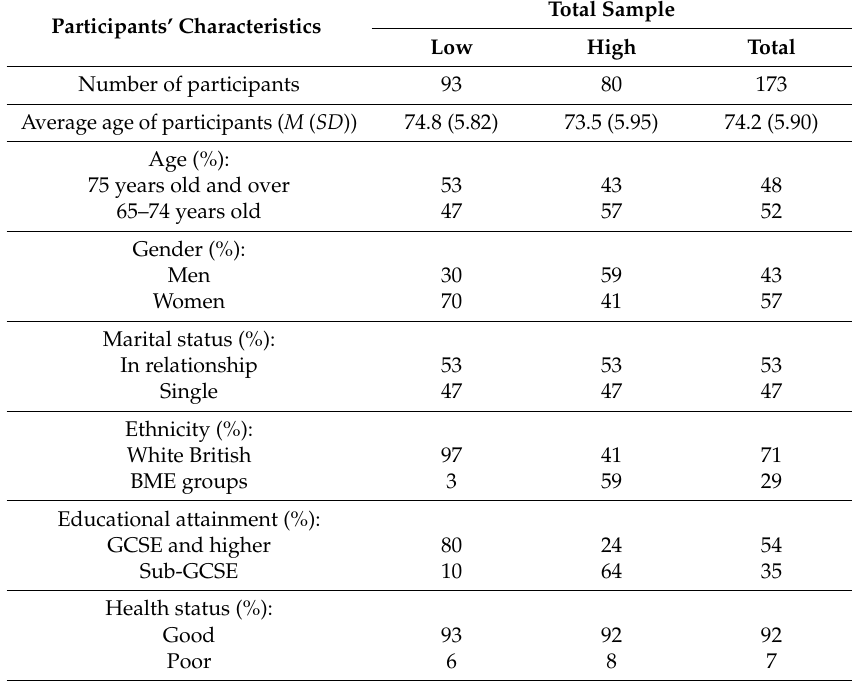
Table 5. Sample characteristics in low- and high-deprivation areas and in